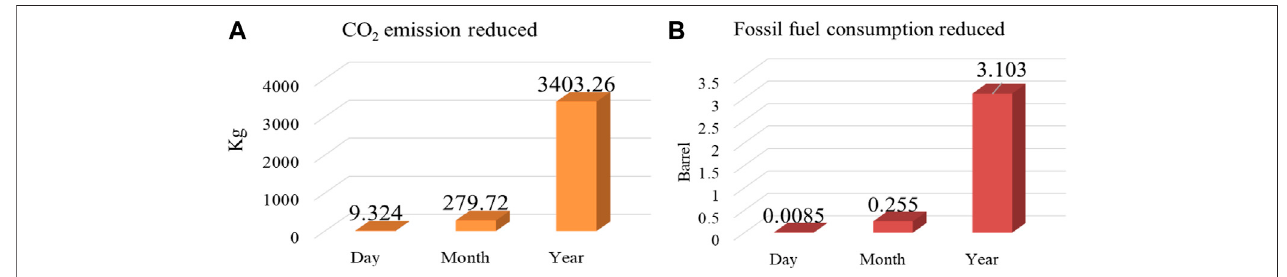
FIGURE 13 | Environmental